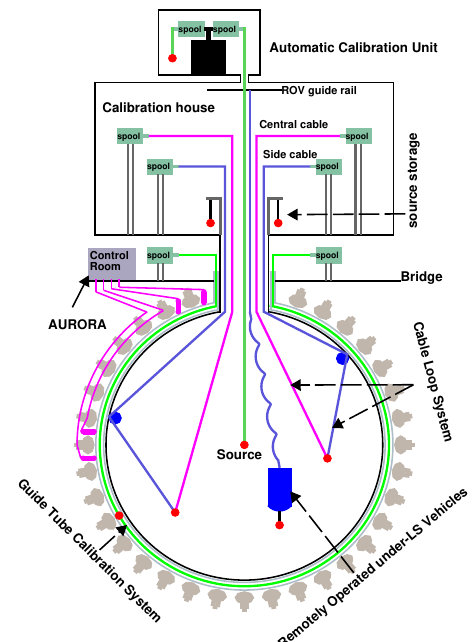
Figure 13 . Overview of the calibration system (not to scale), including the Automatic Calibration Unit (ACU), two Cable Loop Systems (CLSs), the Guide Tube (GT), and the Remotely Operated Vehicle (ROV). The red points represent a source assembly described in figure 4. The AURORA is an auxiliary laser diode system to monitor the attenuation and scattering length of the LS, which is beyond the scope of this